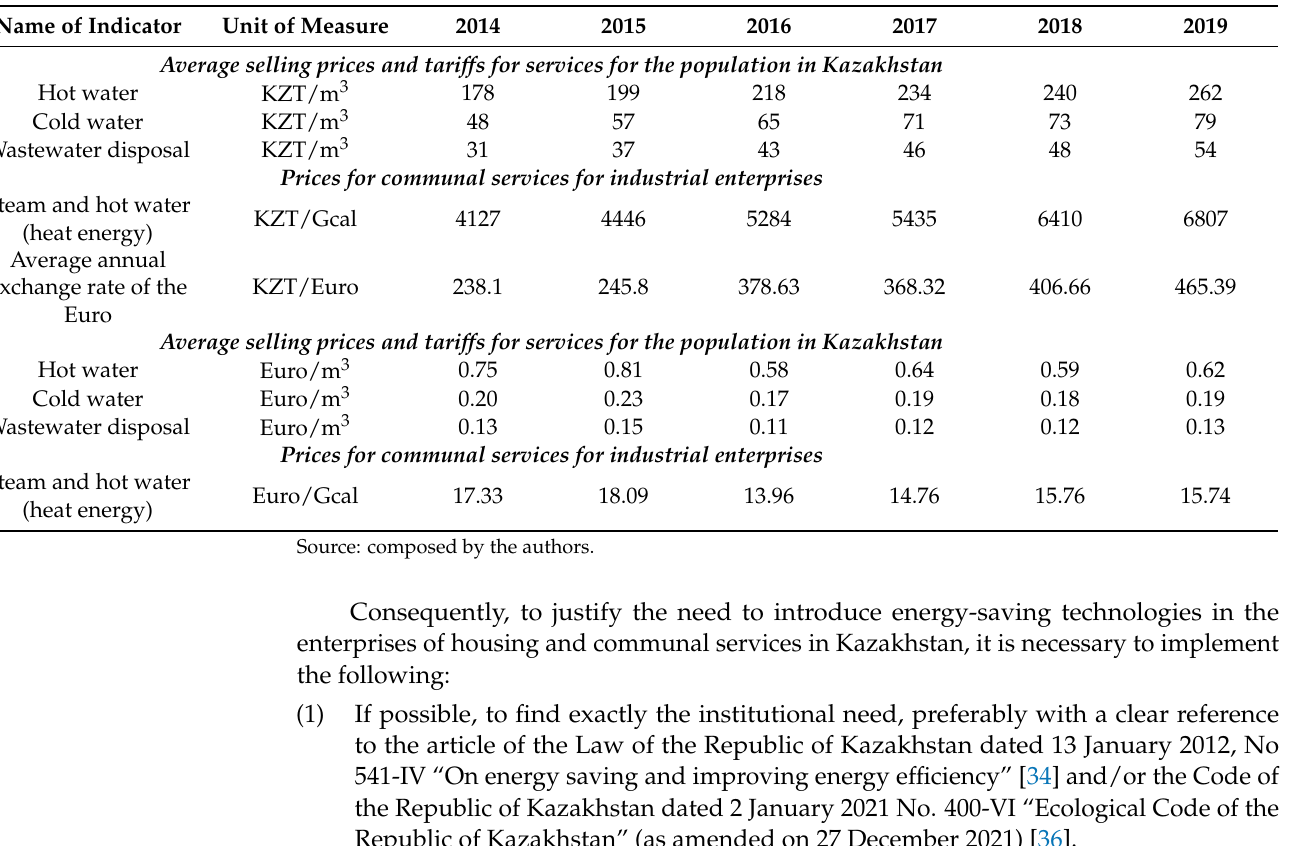
Table 7. Average prices and tariffs for water supply and sanitation in Kazakhstan, end of